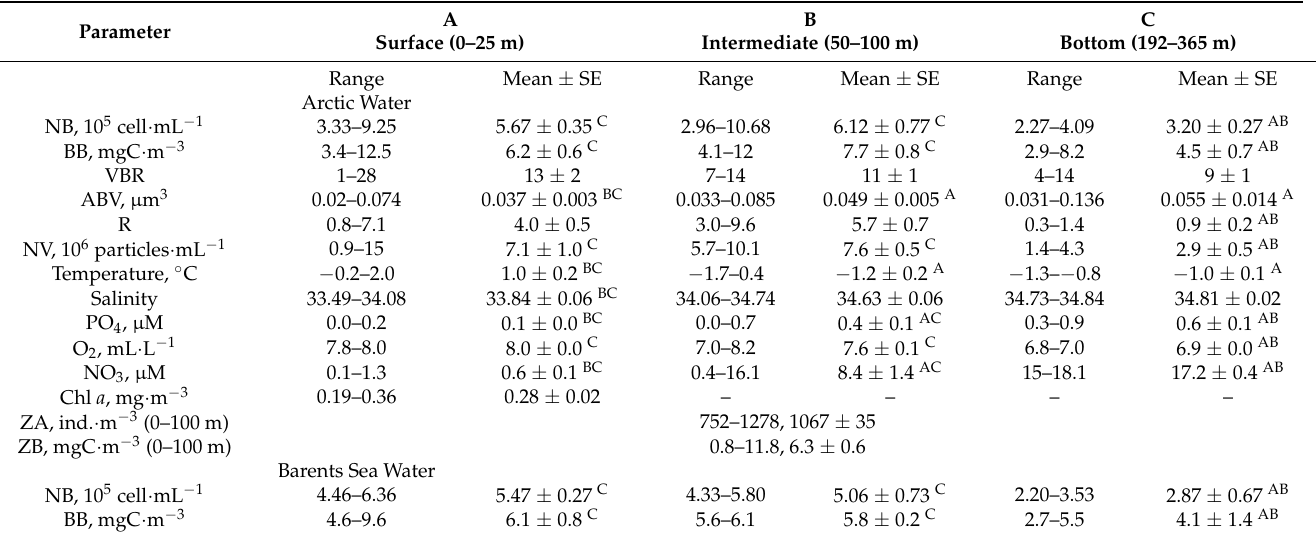
Figure 2. Vertical profiles of temperature, ◦ C ( a ), and salinity ( b ) along the transects in the northeast- ern Barents Sea, in October 2020. Distance shows the intervals between sampling points. Table 2. Environmental parameters and microbial variables in different water masses and sampling layers in the northeastern Barents Sea, in autumn